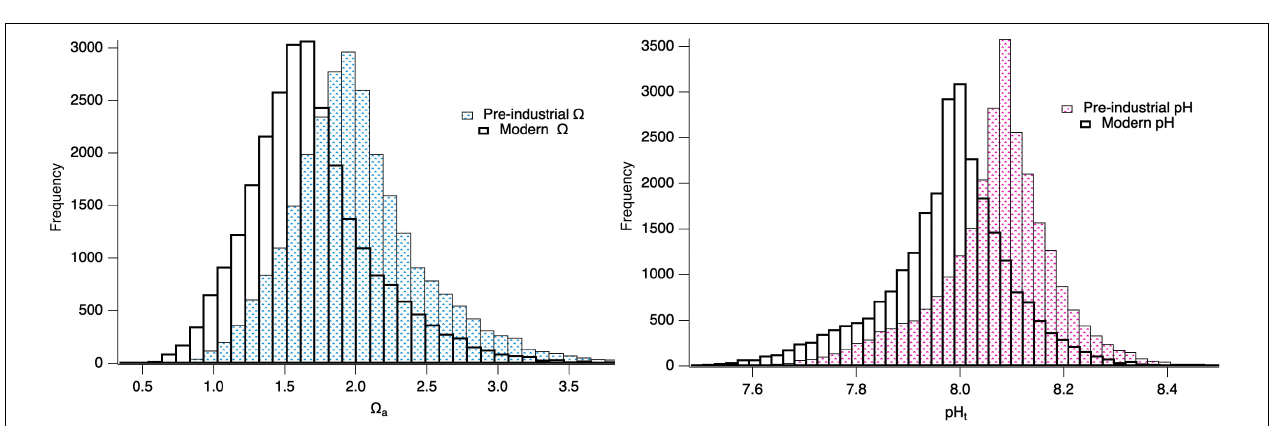
FIGURE 10 | Histogram plot of all hourly calculated (cid:127) a (Left) and pH t (Right) for the 2014–2019 WCSH timeseries.